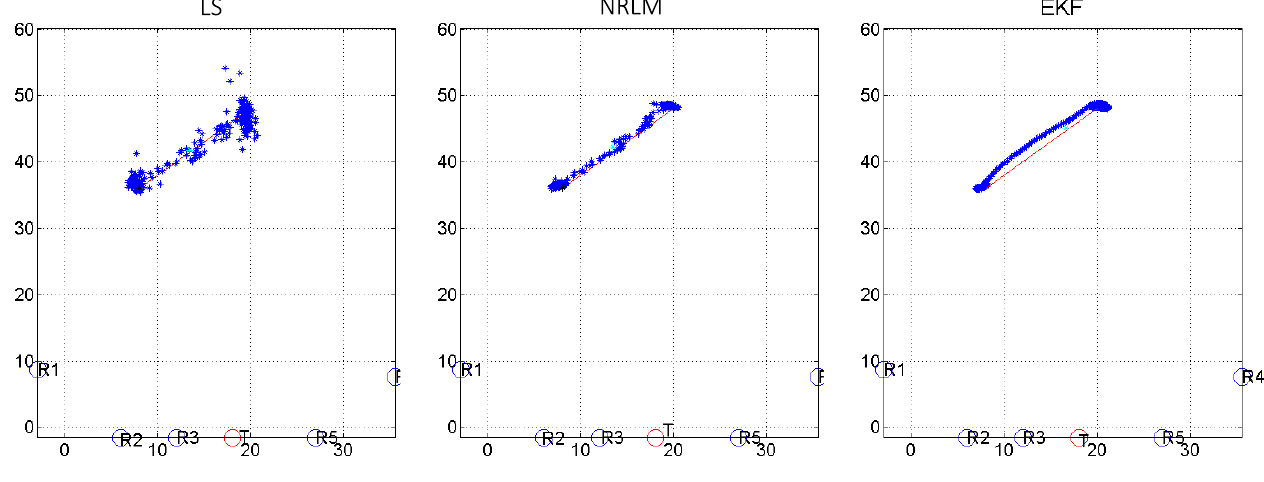
Figure 13. Case 3-2: Target moves from (8, 36) to (20, 48), the velocity of the target is about estimated coordinates of moving target; red line: the reference target